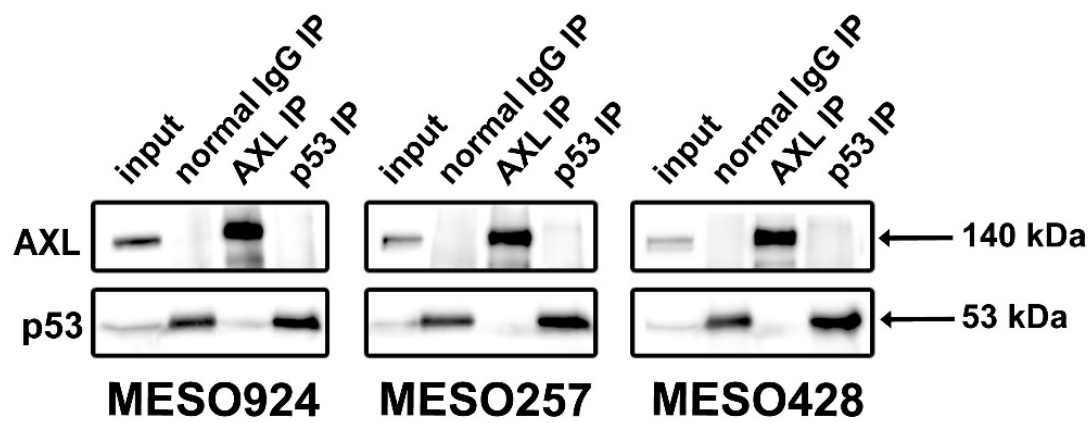
Figure 3. AXL/p53 Immunoprecipitations followed by AXL and p53 immunoblotting in mesothelioma cell lines (MESO924, MESO257, and MESO428) do not show interaction between AXL and